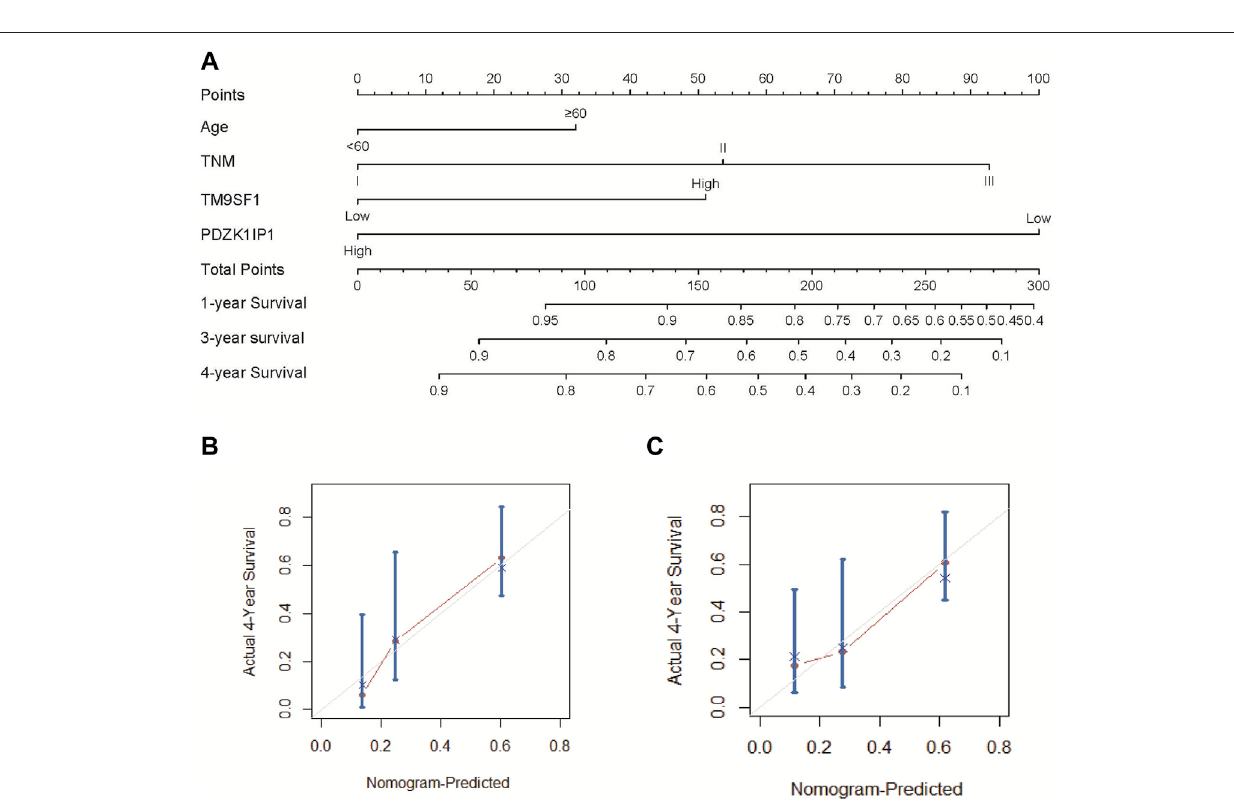
Frontiers in Bioengineering and Biotechnology |